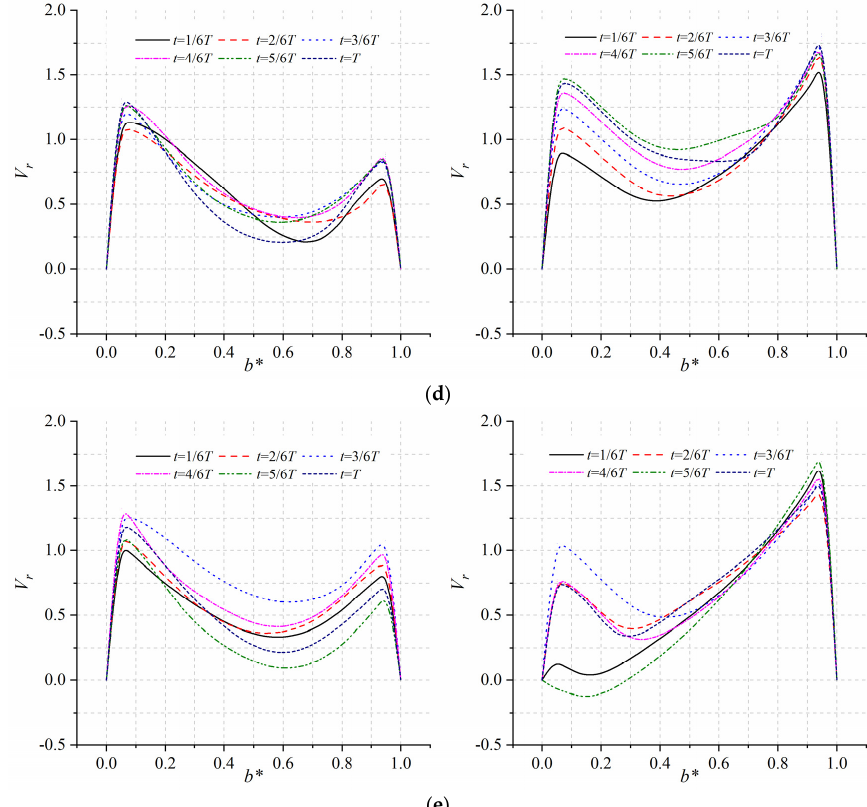
Figure 9. ( a – e ) Distributions of instantaneous normalized radial velocity along the hub-to-shroud direction for flow near the pressure surface (left) and suction surface (right) for (from top to bottom) U rot /U ref = − 0.5, − 0.3, 0.0, 0.3 and 0.5.